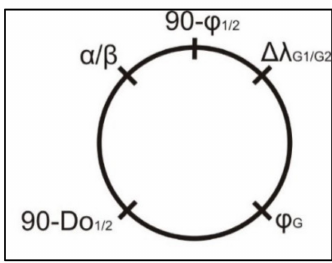
Figure 4. Napier wheel composite great circle navigation